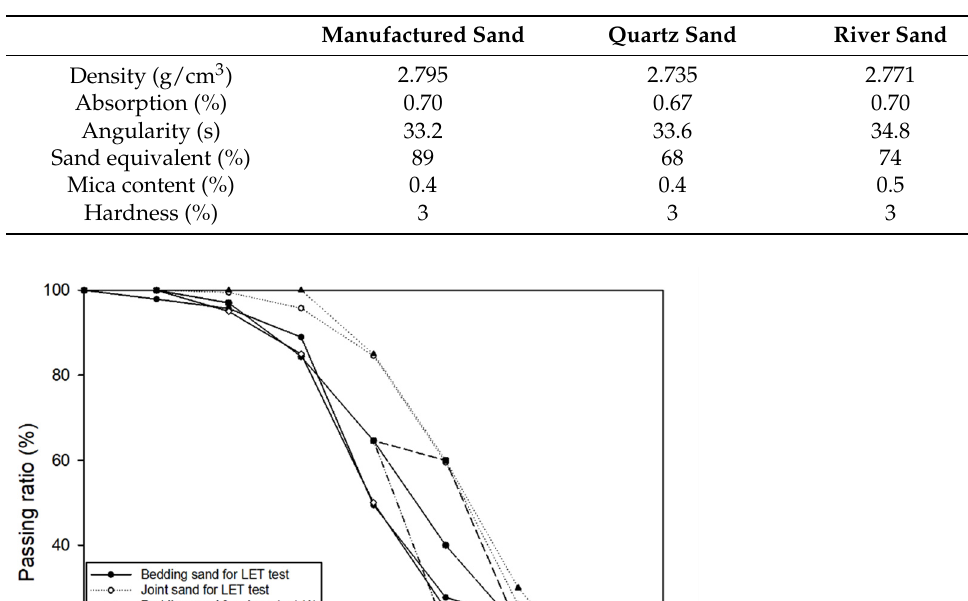
Table 1. Basic physical properties of sand.